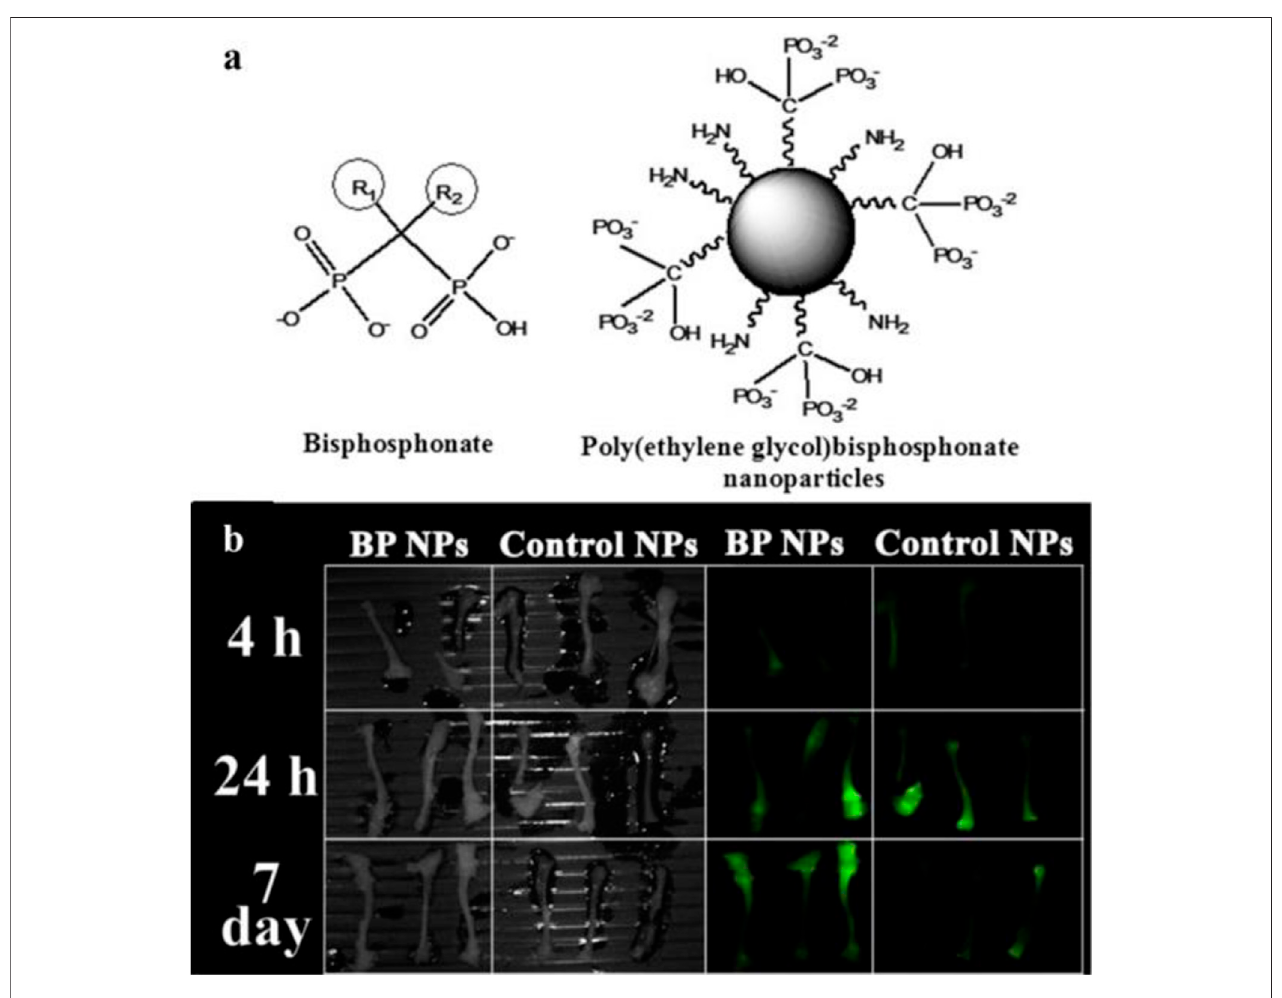
FIGURE1| Nanoparticles with bisphosphonates (BPs)functionalgroups couldtargetbone. (A) Chemical structure ofBPand poly(ethylene) BPnanoparticles. (B) NIR fl uorescence imaging of the bones extracted from mice treated with Cy7-labeled BP NPs. Reproduced with permission from Rudnick-Glick et al. (2015).